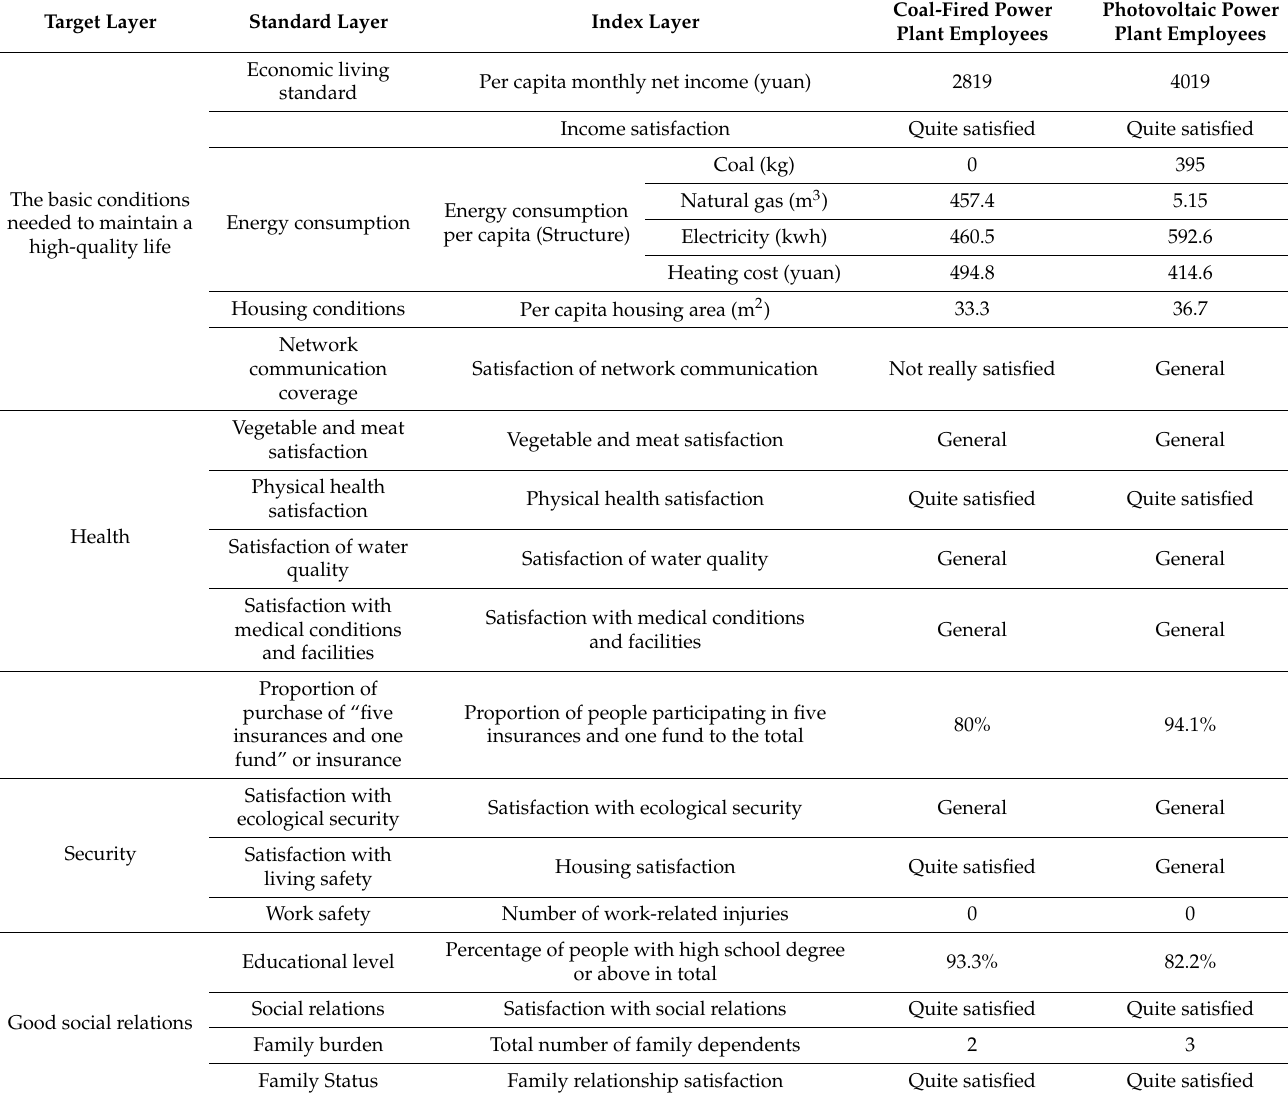
Table 7. Comparison of employee well-being indicators in coal-fired power plants and photovoltaic power